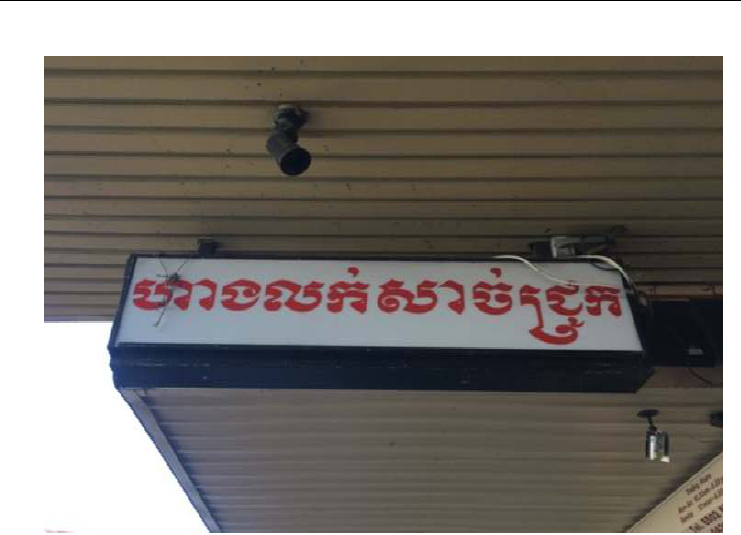
Figure 1. One language sign